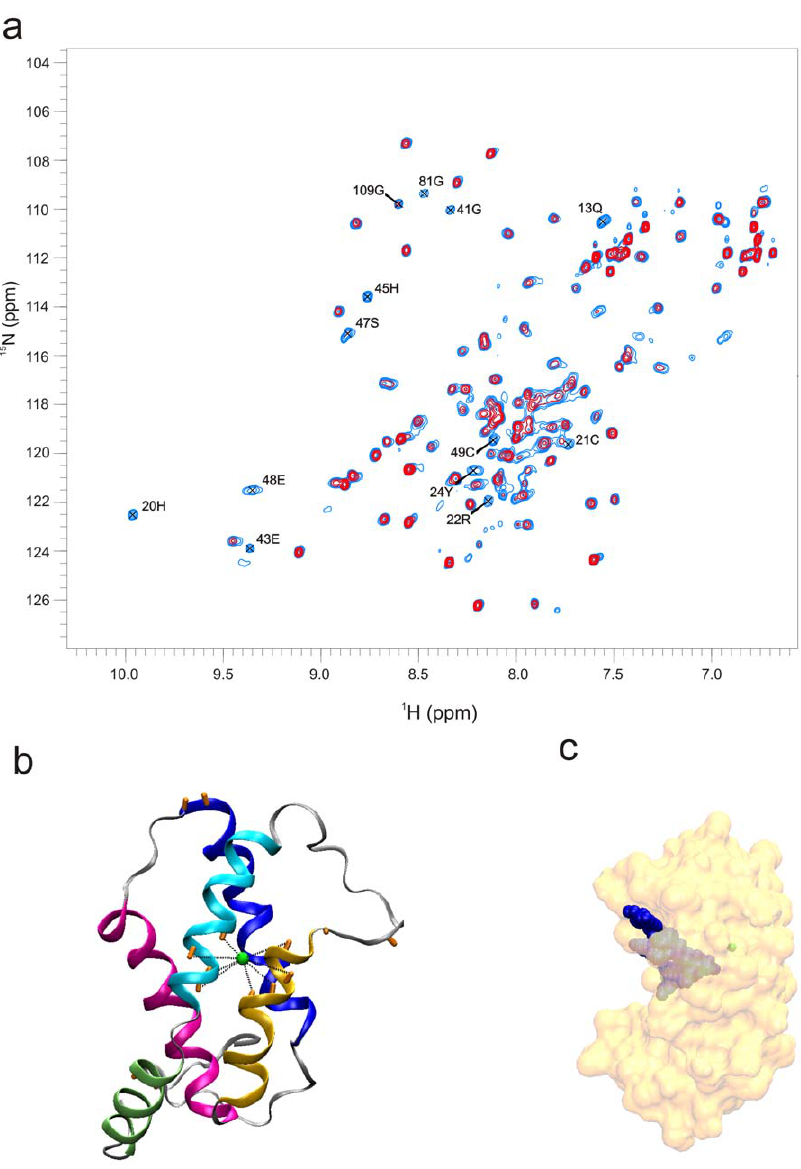
Figure 4. Ber e 1 copper interaction. a) Paramagnetic copper relaxation enhancement experiment on Ber e 1. The spectrum shown in black is recorded in the absence of copper, whereas the spectrum shown in red has copper added in a 1:1 (Cu 2 + :Ber e 1) stoichiometry. N-H groups in the backbone affected by paramagnetic relaxation enhancement by the addition of Cu 2 + in a 1:1 ration are HIS 20, CYS 21, ARG 22, TYR 24, GLU 43, HIS 45, SER 47, GLU 48, CYS 49, and GLN 52. In addition N-H groups form sidechains (s.c) of GLN 11, 13, 28 and 83 are also affected by Cu 2 + at this stoichiometric ratio. b) A model of the copper atom positioning in Ber e 1, based on the nearby residues identified in (a). The N-H backbone groups that are bleached are indicated in the structure as orange rods. c) Due to the slow dynamics around the copper binding site, the copper atom is engulfed into the core of the protein. Interestingly, its position is very close to the bottom of the hydrophobic cavity.